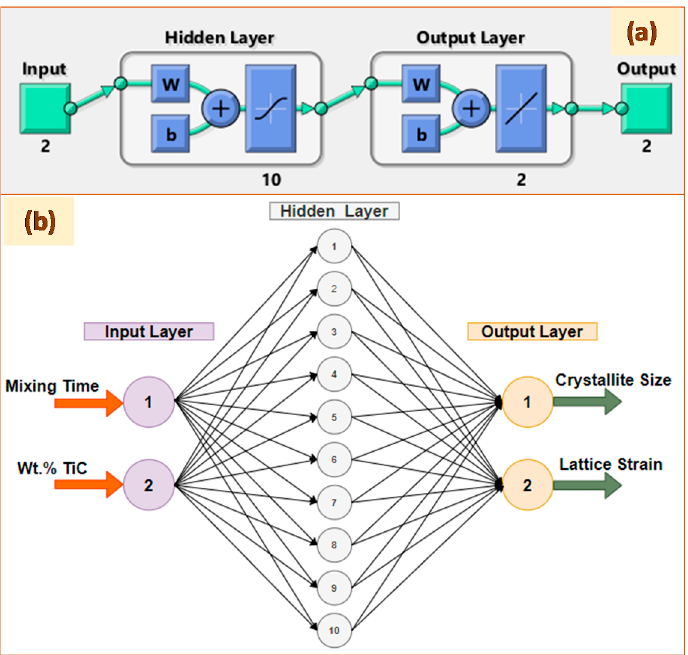
Figure 3. The ANN architecture of the three-layered neural network proposed in this study: ( a ) flow diagram obtained from MATLAB and ( b ) schematic details of the layers.